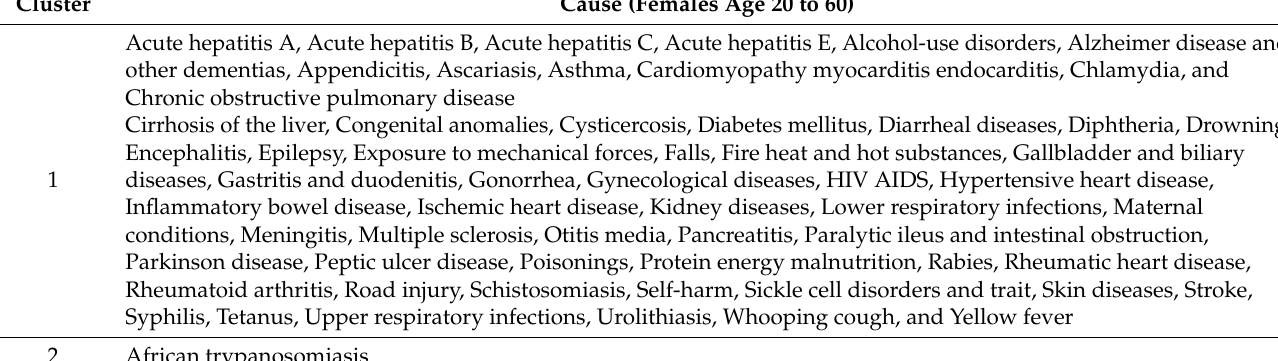
Table A5. Cluster members for females aged 20 to